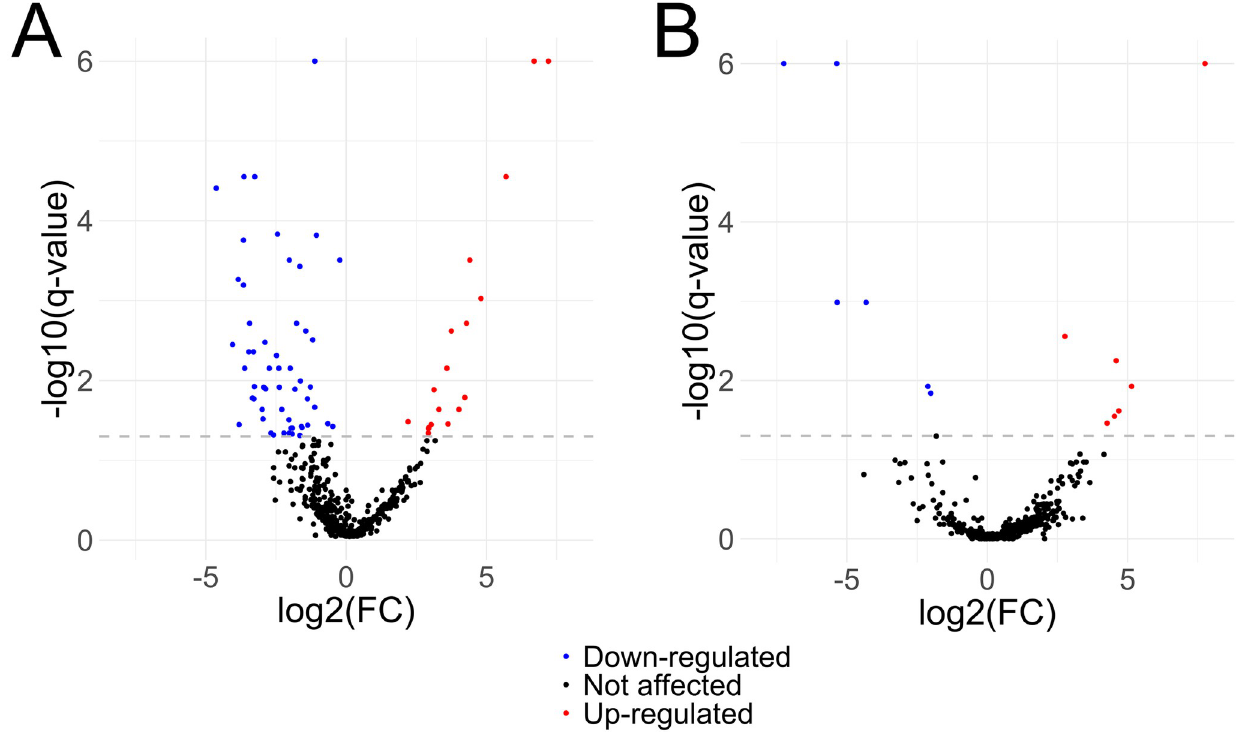
Fig 3. Volcano plots of the significantly differentially expressed proteins in tegument (A) and somatic extract (B) of F . hepatica juveniles after passing through mouse intestinal wall. The grey dashed line represents the threshold delimiting the differentially expressed proteins. Red dots represent upregulated proteins, while blue dots represent downregulated